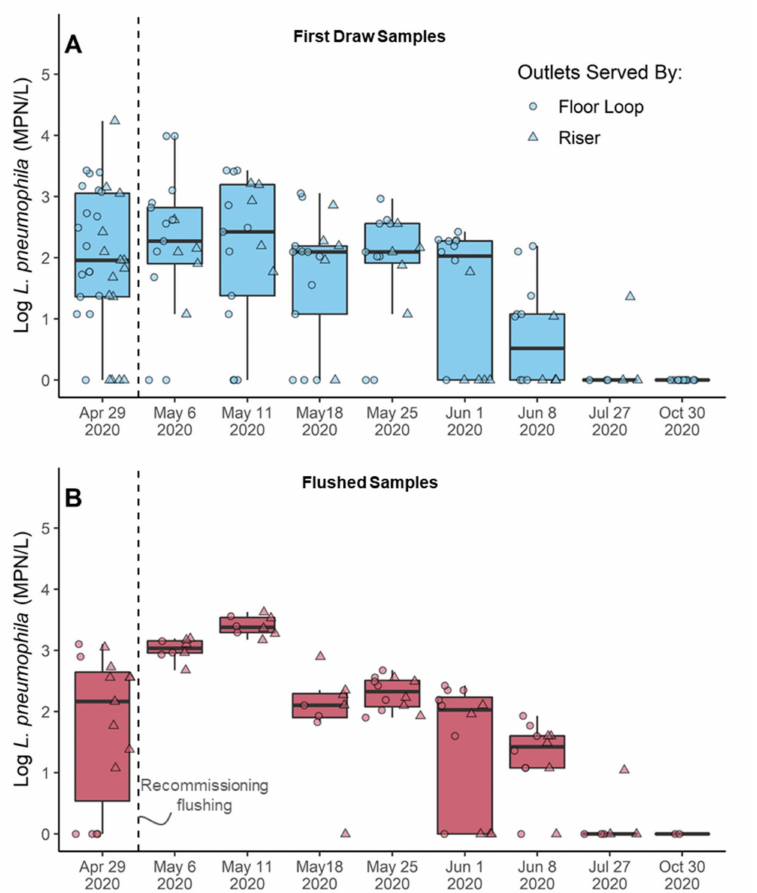
Figure 3. L. pneumophila culture numbers in hot water samples collected on a day the boiler was operated at 45 ◦ C in ( A ) first draw and ( B ) 5-min flushed samples just before and several weeks after recommissioning flushing. Boxplot bodies reflect the 25th, 50th, and 75th percentile; whiskers represent 1.5 times the interquartile range. Raw data is overlaid onto the boxplots. ◦ indicates samples collected from passive floor loops (laboratory outlets); ∆ indicates samples collected from hot water risers (outlet in lavatories and